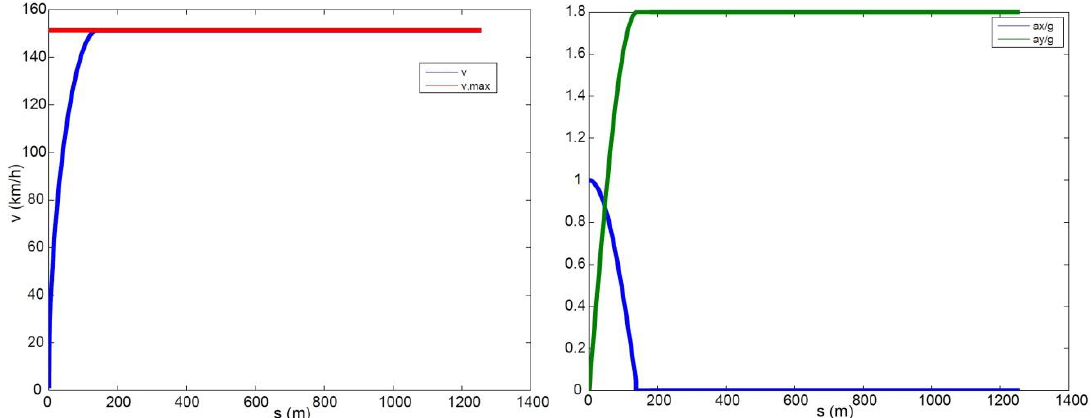
Figure 5. Circumference, no aerodynamics, R = 100 m: (left) speed and (right) accelerations with respect to 𝑠 .